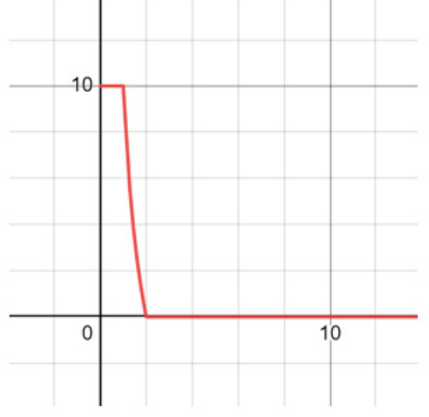
Figure 13. The graphic and the formula used for three users to collaboratively move a virtual artifact only when they coordinate their acceleration in the x-direction with a certain precision.